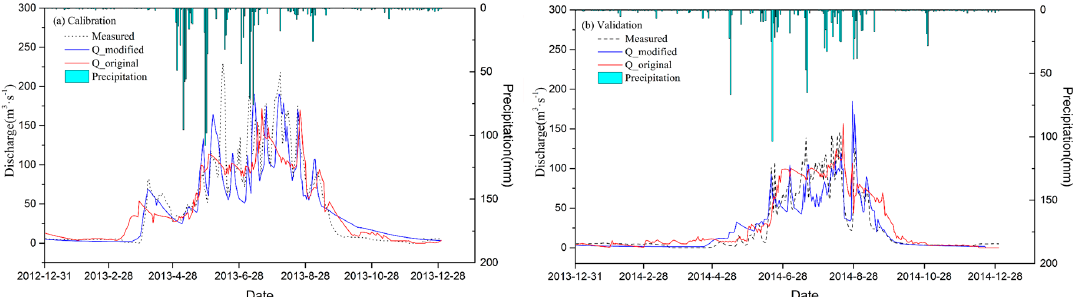
Figure 5. Simulation results of the model on the daily scale: ( a ) Represents the comparison of precipitation, simulation, and observation during the calibration period; ( b ) represents the comparison of precipitation, simulation, and observation during the validation period.